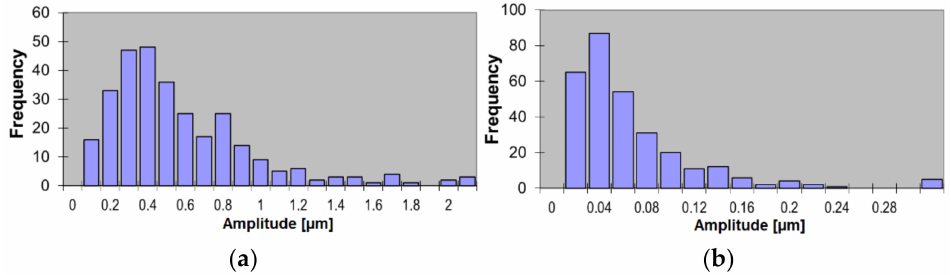
Figure 8. Histograms of roundness deviation RONt measured on 100 cylinders: ( a ) second harmonic; ( b ) fifth harmonic.